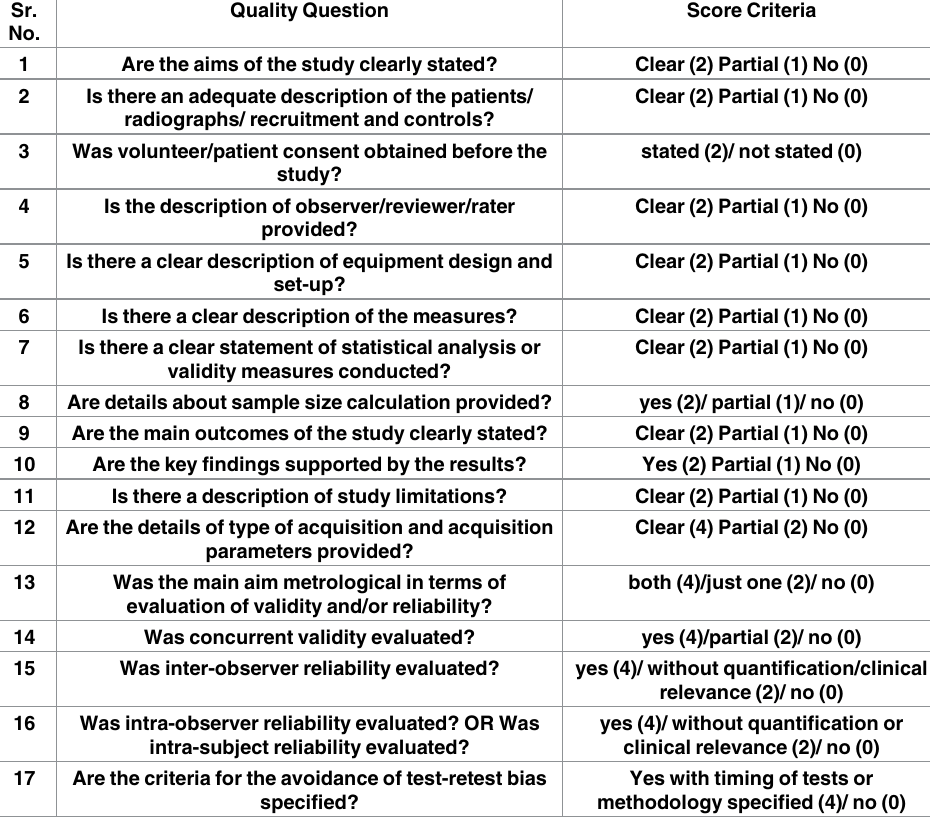
Table 1. Quality assessment score (QAS) questionnaire used to evaluate the quality of each selected article. Sr.